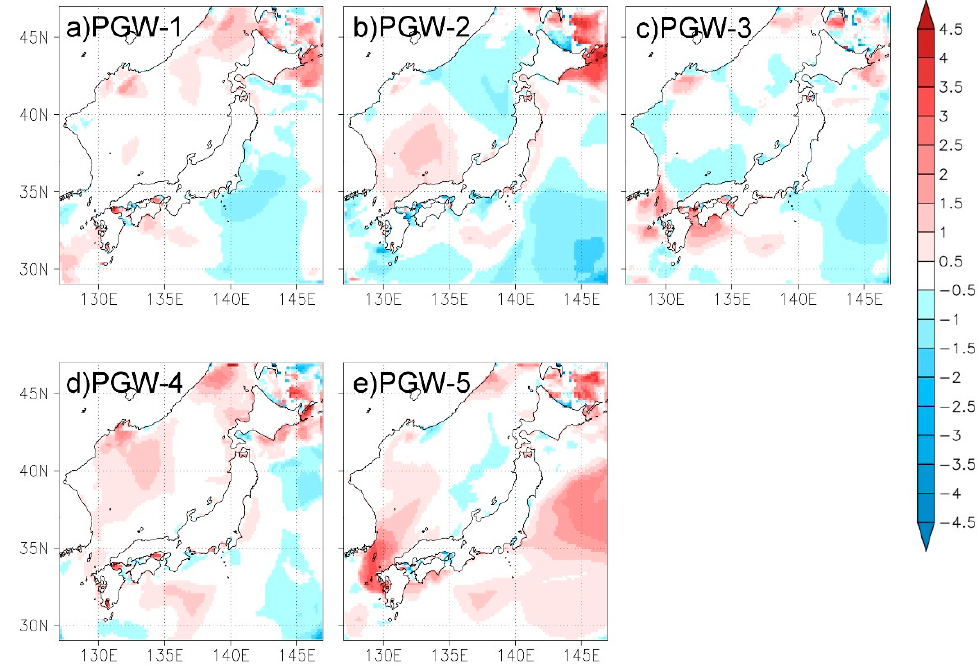
Figure 10. ( a )–( e ) Future variations of T m_max in each PGW simulation. Unit of color bar is